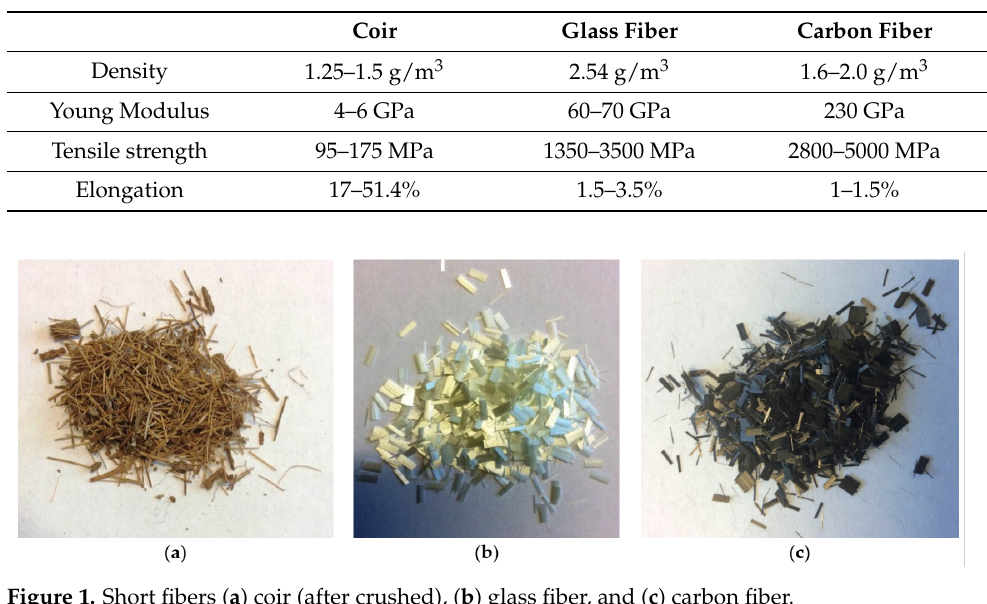
Table 4. Selected physical and mechanical properties of fibers [17–24].